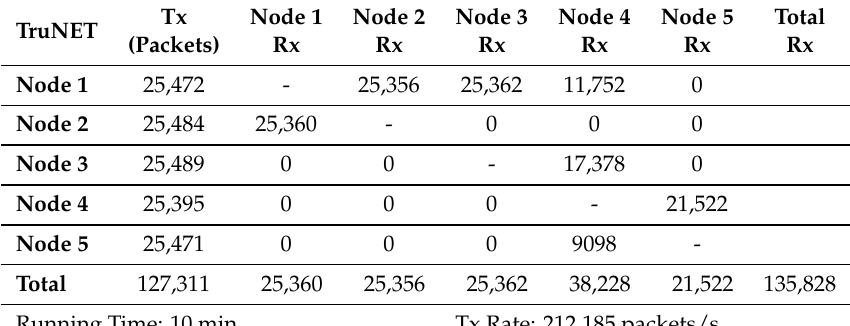
Table 5. Packet delivery: TruNET wireless.